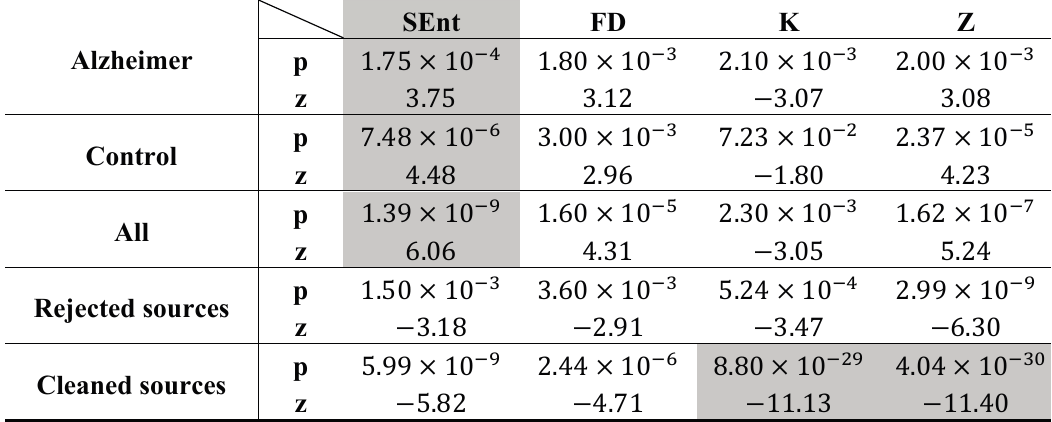
Table 2. Statistical comparison of the features for artifacts sources versus clean sources (two-sided Wilcoxon ranksum test) for the group of 17 patients suffering from Alzheimer’s disease, for the group of 24 control subjects, for all 41 subjects aggregated, and group effects comparing rejected sources between Alzheimer and Control groups and the clean sources between Alzheimer and Control groups. All measures from the three experts were aggregated for this test. Rows indicate p-values and the Wilcoxon z-score statistic. Gray background indicates the most powerful feature (sample